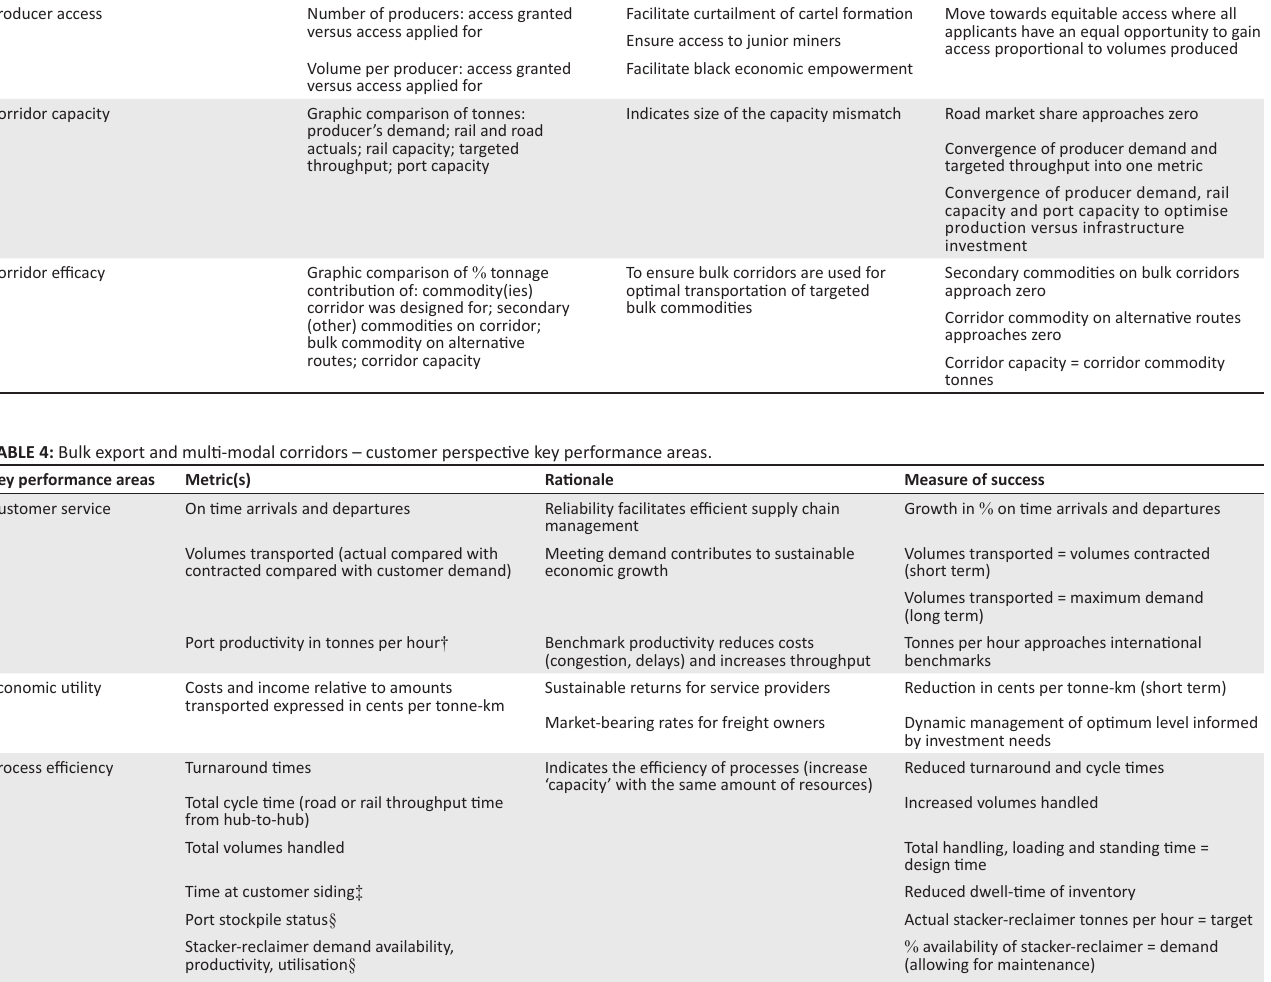
Cost impact of optimal modal split (all bulk on rail)